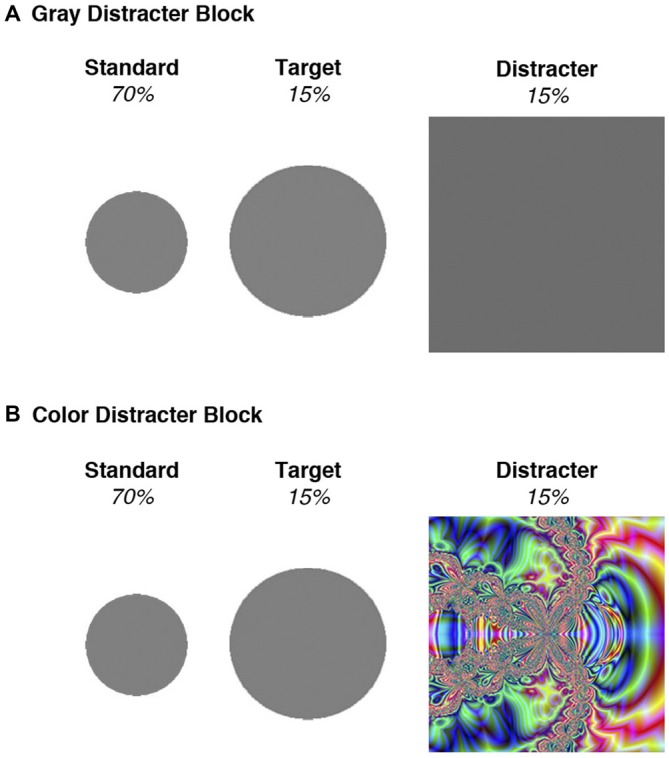
Stimuli used in the two blocks of the oddball task. (A) All stimuli in the gray distracter block were comprised of an identical gray color. (B) Standards and targets in the color distracter block were identical to those presented in the gray distracter block, but the distracters consisted of unique colorful fractal designs.